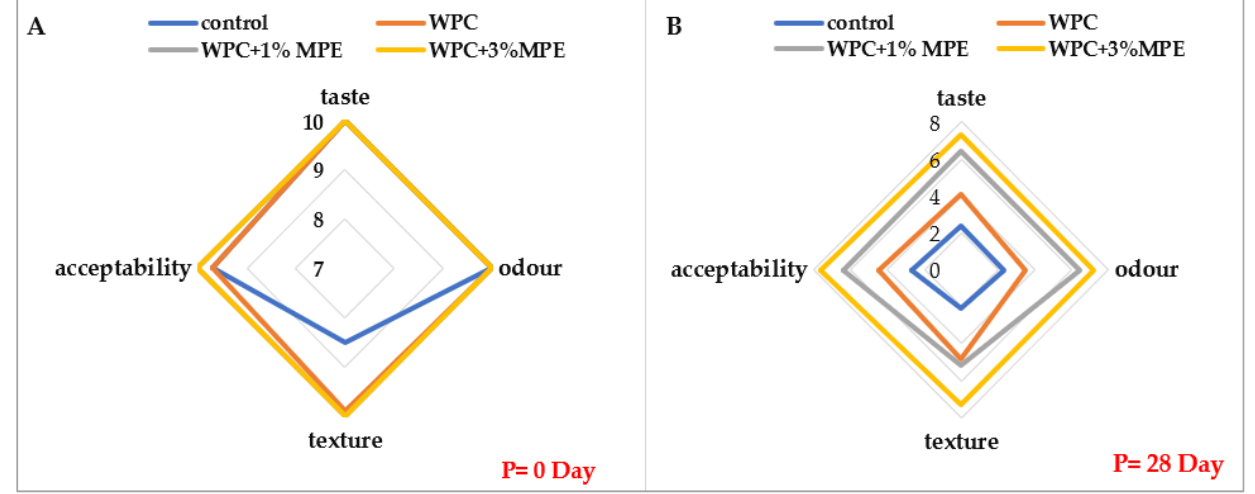
Figure 9. A hedonistic scale of broccoli fresh-cuts (WPC = whey protein concentrate alone, WPC + 1% MPE = whey protein concentrate + mango peel extract at 1% and WPC + 3% MPE = whey protein whey protein concentrate + mango peel extract at 3%) on period (P) = 0 day ( A ) and P = 28 day ( B ).